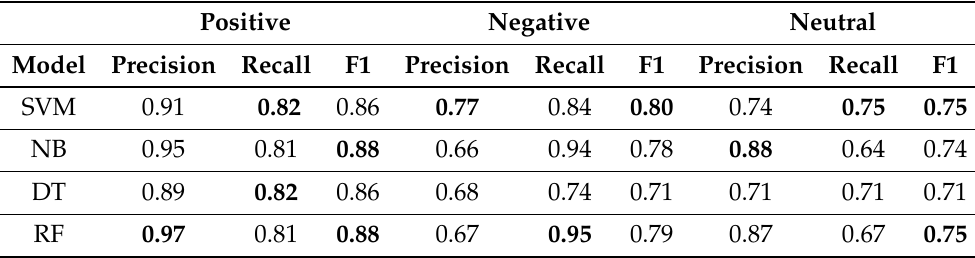
Table 2. Tweet sentiment classification accuracy: 3-class, balanced data set.